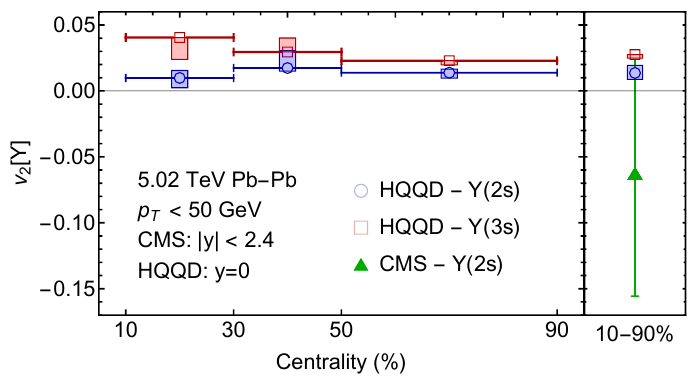
Figure 8 . Centrality dependence of v 2 [Υ(2 s )] and v 2 [Υ(3 s )] in the same centrality bins as figure 7. Open symbols are predictions of HQQD. In the 10–90% class we include recent data reported by the CMS collaboration for integrated v [Υ(2 s )] [83]. The shaded red and blue boxes associated 2 with each HQQD prediction indicate the systematic variation observed when changing the model parameters in the range specified in eq.